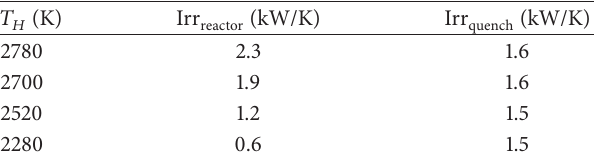
and Irr as a function of 𝑇 𝐻 for Tb-WS cycle. reactor quench